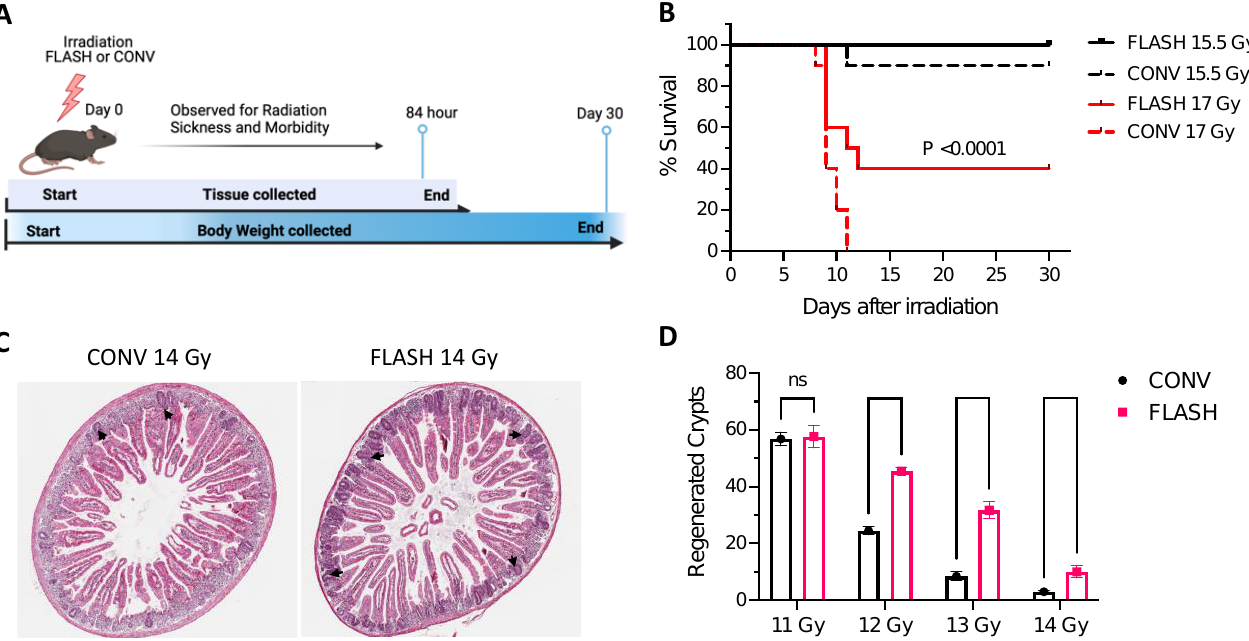
Figure 1. At MD Anderson, ultra-high dose rate FLASH radiation therapy (RT) led to higher survival and reduced gastrointestinal toxicity compared with conventional dose rate (CONV) RT in mice subjected to whole-abdominal irradiation. ( A ) Schematic of radiation schedule treatment and follow-up at MD Anderson. ( B ) Kaplan–Meier plot shows percent survival at 30 days after irradiation with FLASH RT or CONV RT at two different doses (n = 10/group). Survival rates were higher for the mice treated with 15.5 Gy than for mice treated with 17 Gy in both groups ( p < 0.0001, log-rank test). FLASH-treated mice showed higher survival than CONV-treated mice. ( C ) H&E-stained transverse sections of jejunum at 84 h after a single 14-Gy dose showing differential response in regenerated crypts. ( D ) Numbers of regenerated crypts per circumference for mice given 11, 12, 13, or 14 Gy by CONV RT or by FLASH RT. Number of regenerated crypts are significantly higher in all FLASH groups compared to the dose-matched CONV groups at doses of 12 Gy and higher. ns – not significant, * p < 0.05; ** p < 0.001; *** p < 0.0001; **** p < 0.00001, unpaired Student’s t -tests